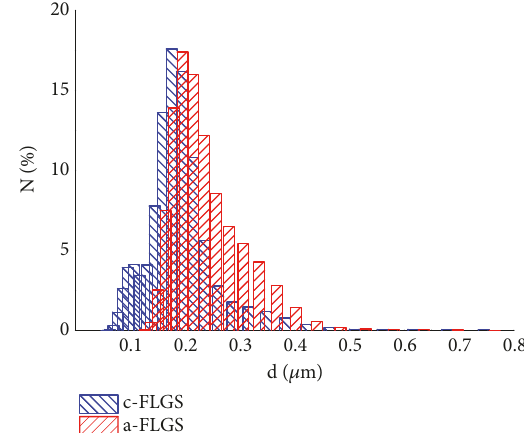
Figure 1: Size distribution of c-FLGS (blue) and a-FLGS (red) particles.